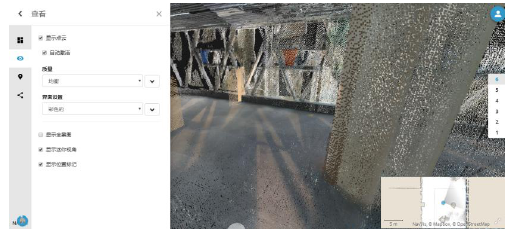
Figure 4.Point cloud after registration